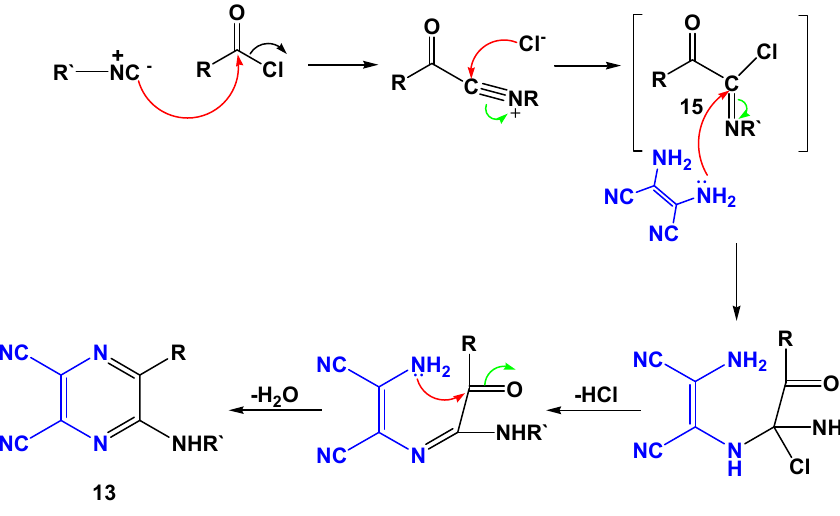
Scheme 2. Mechanism of pyrazines 13 formation.